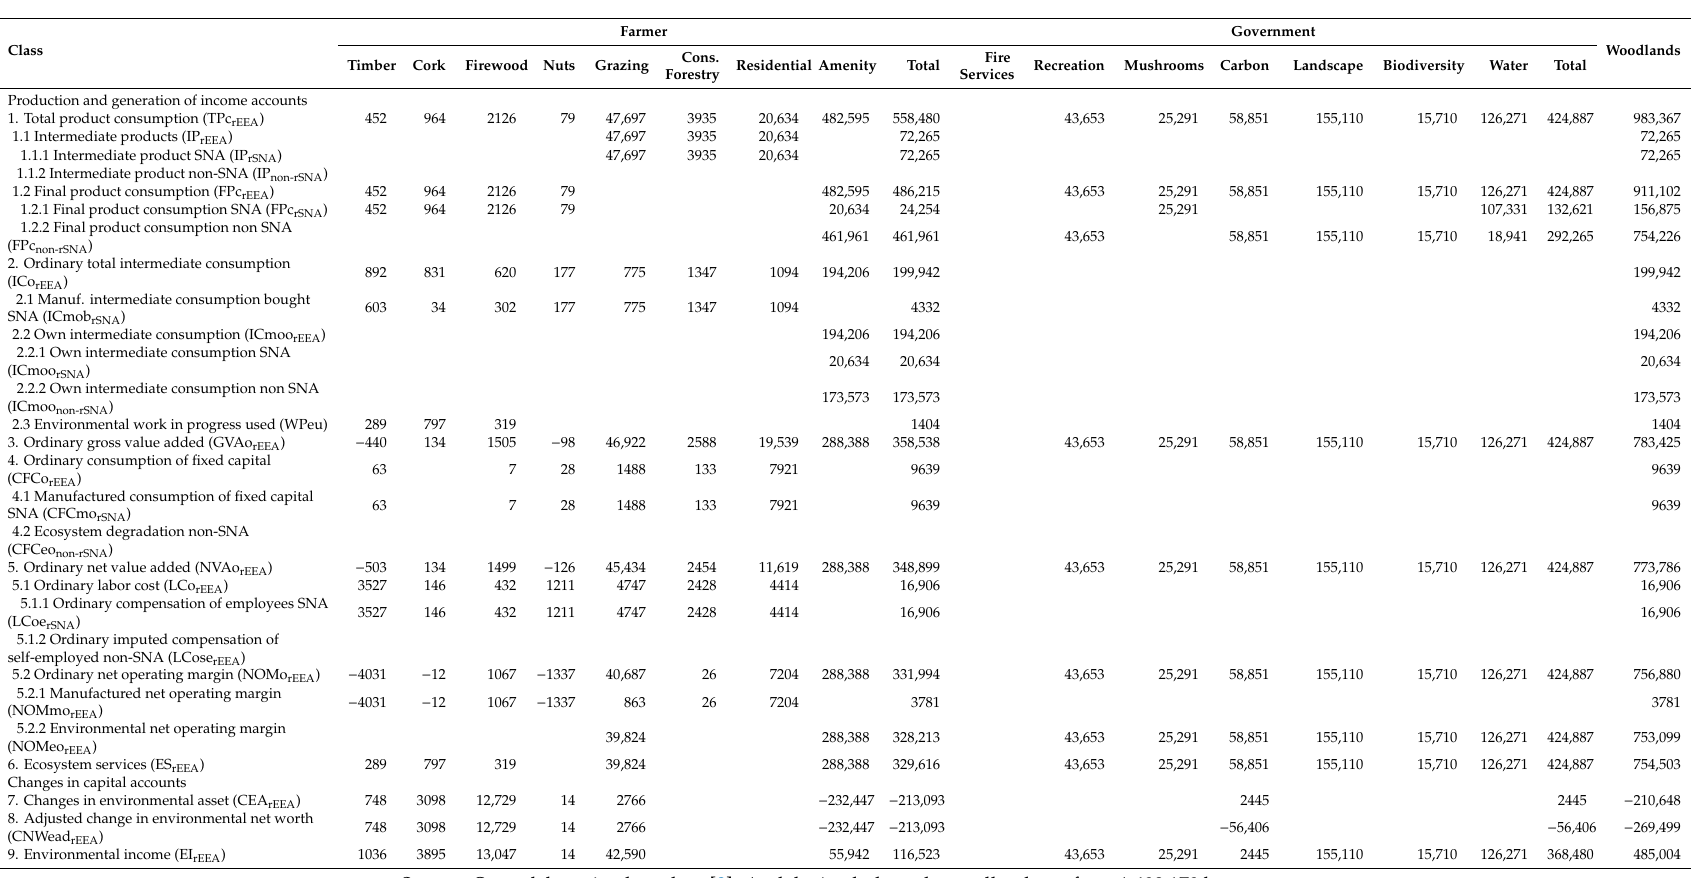
Table A3. Stylized sequence of accounts of the refined System of Environmental Economic Accounting–Experimental Ecosystem Accounting applied in holm oak open woodlands in Andalusia, Spain (2010: thousands of